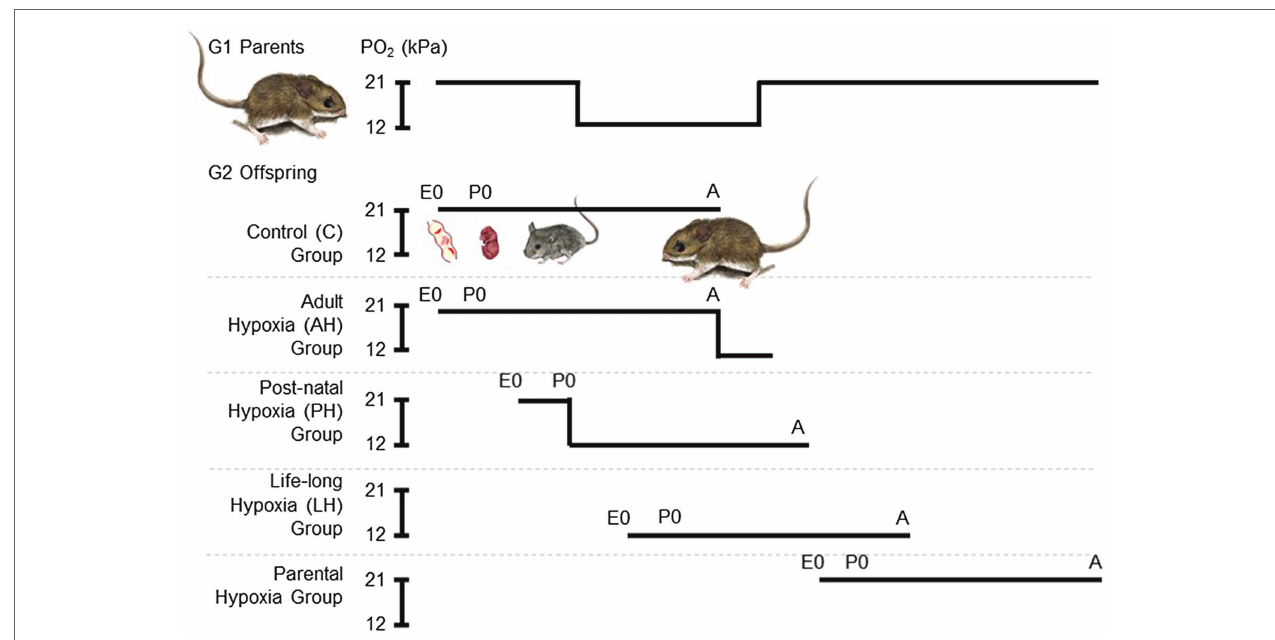
FIGURE 1 | Experimental treatment groups used to evaluate the effects of chronic hypoxia at different life stages. We used a standardized breeding design with first generation (G1) lab-raised parents to expose second generation (G2) lab-raised offspring to hypoxia starting at multiple life stages. Each breeding pair conceived and raised their 5th and 6th litters in normobaric normoxia until weaning. These progeny were split into two treatment groups, one that remained in normoxia (~21 kPa O 2 ; control group, C) and the other that was acclimated to hypobaric hypoxia (~12 kPa O 2 ) for 6–8 weeks during adulthood (adult hypoxia group, AH). Litter 7 was conceived and born in normoxia, but parents and offspring were moved to hypobaric hypoxia within 12 h of birth, and offspring were weaned and raised to adulthood in hypobaric hypoxia (post-natal hypoxia group, PH). The mother and father continued to be held in hypobaric hypoxia, and were allowed to conceive litter 8, which was born and raised into adulthood in hypobaric hypoxia (life-long hypoxia group, LH). After weaning litter 8, breeding pairs were returned to normoxia and were then allowed to conceive and raise litter 9 in normoxia (parental hypoxia group). Full details of the breeding design can be found in the Methods. E, embryonic age in days; P, post-natal age in days; A, adult; and PO 2 , partial pressure of O 2